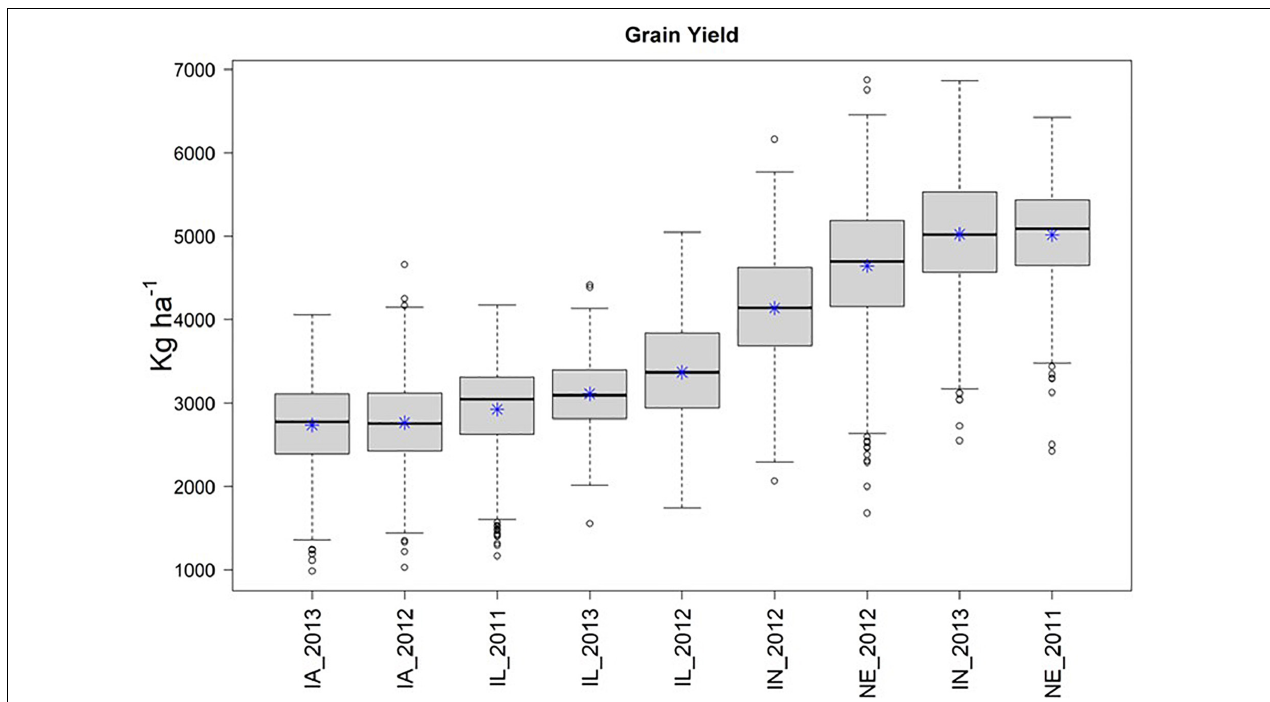
FIGURE 2 | Boxplot of yield in kg ha − 1 ( Y -axis), by environment ( X -axis) for the second random sample of 500 genotypes from the SoyNAM panel, and * represents the sampling mean. Environments IA_2013, IA_2012, and IL_2011 had the lowest yield, while IN_2013 and NE_2011 had the highest yield. TABLE 2 | Mean Pearson correlation coefficient of grain yield (in kg ha − 1) between each environment and the remaining eight environments (presented under the columns labeled “Average Correlation”), as well as the observed heritability of grain yield within each environment (presented under the columns labeled “Heritability”). Environment Average Correlation